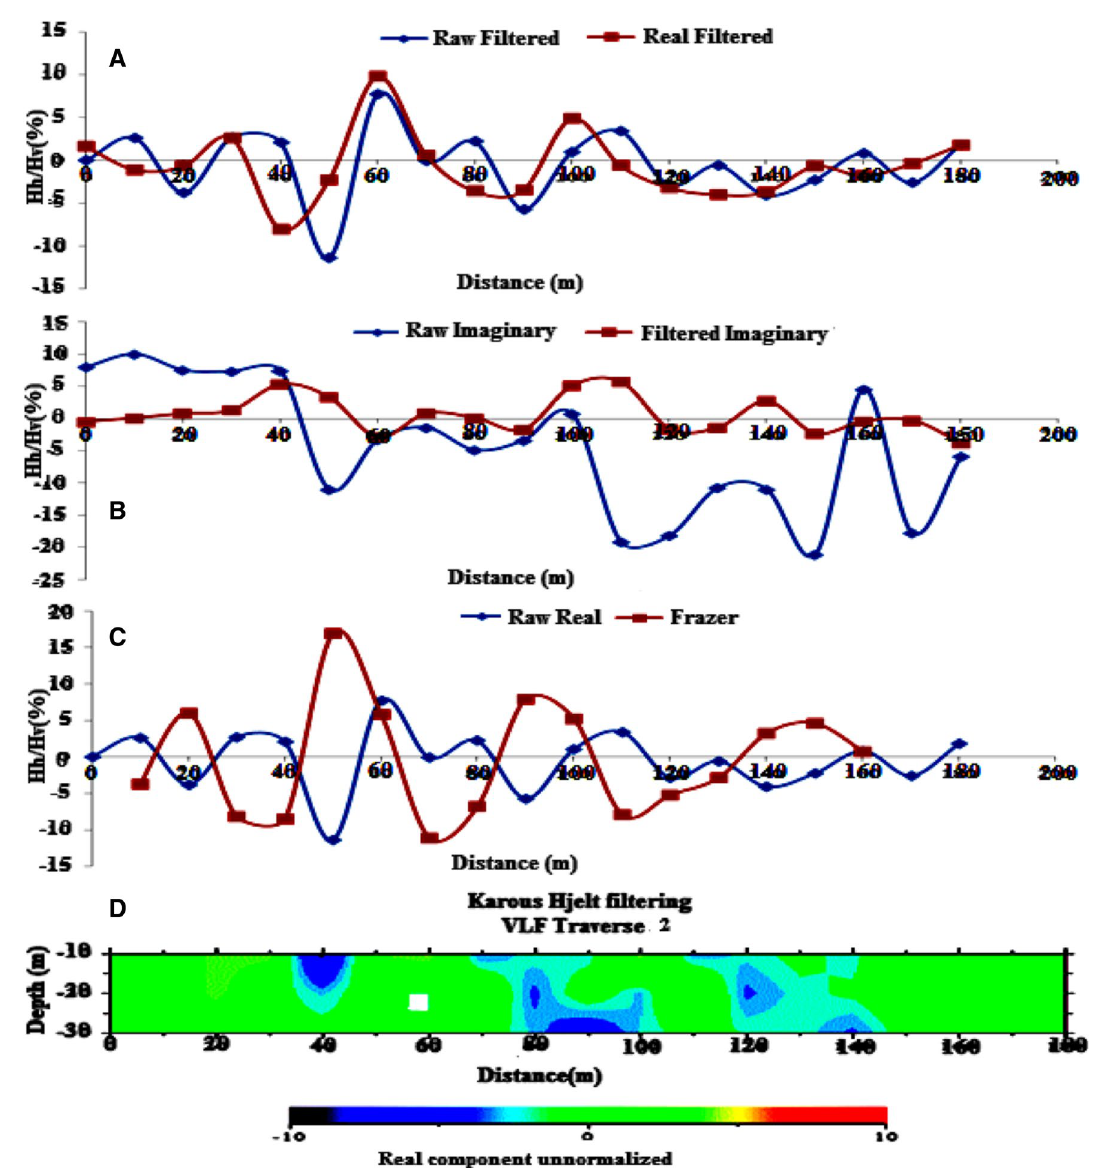
Fig. 3 VLF-EM profile 1 along east-west direction a Plot of raw and filtered imaginary against distance b Plot of imaginary raw and filtered against distance c Frazer filtering against distance